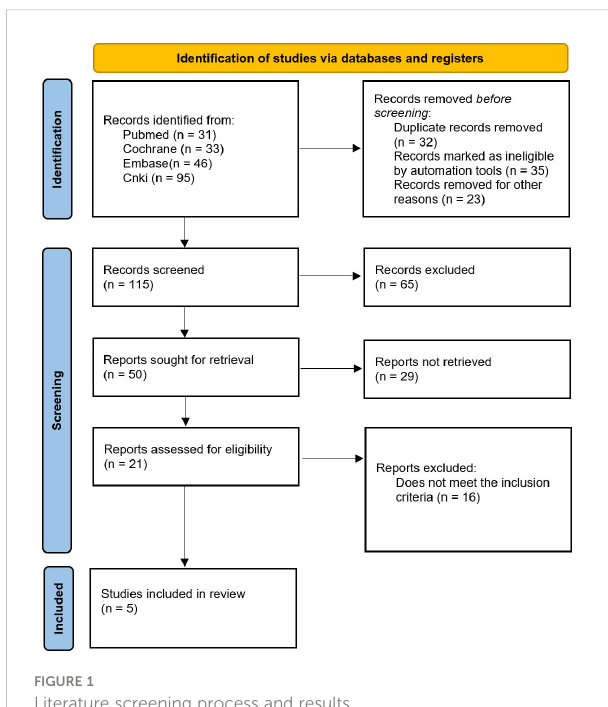
FIGURE 1 Literature screening process and